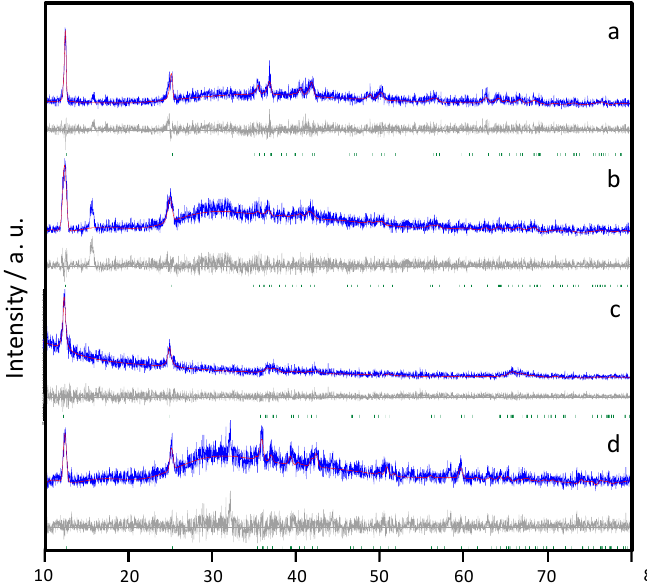
Figure 2. Powder XRD patterns of as-prepared birnessite samples: ( a ) Na-B / SS, ( b ) Na-B / HT, ( c ) K-B / SS, ( d ) K-B / HT. Blue: experimental profile, red: calculated profile, grey: di ff erence profile, grey lines: peak positions. The CIF files provided in [10] were used as reference. This file is available in the Crystallography Open Database (COD), http://www.crystallography.net/. The original data for this